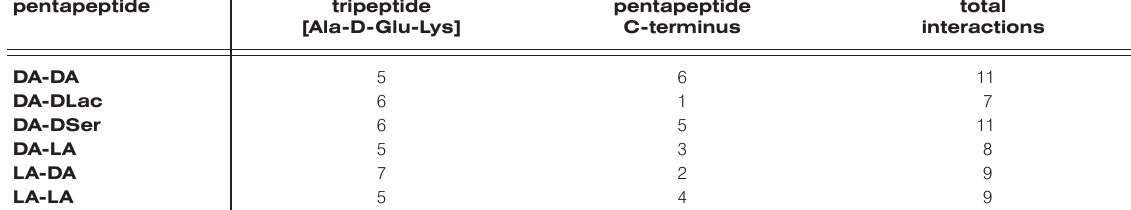
Table 2. The number of polar interactions per pentapeptide fragment. pentapeptide